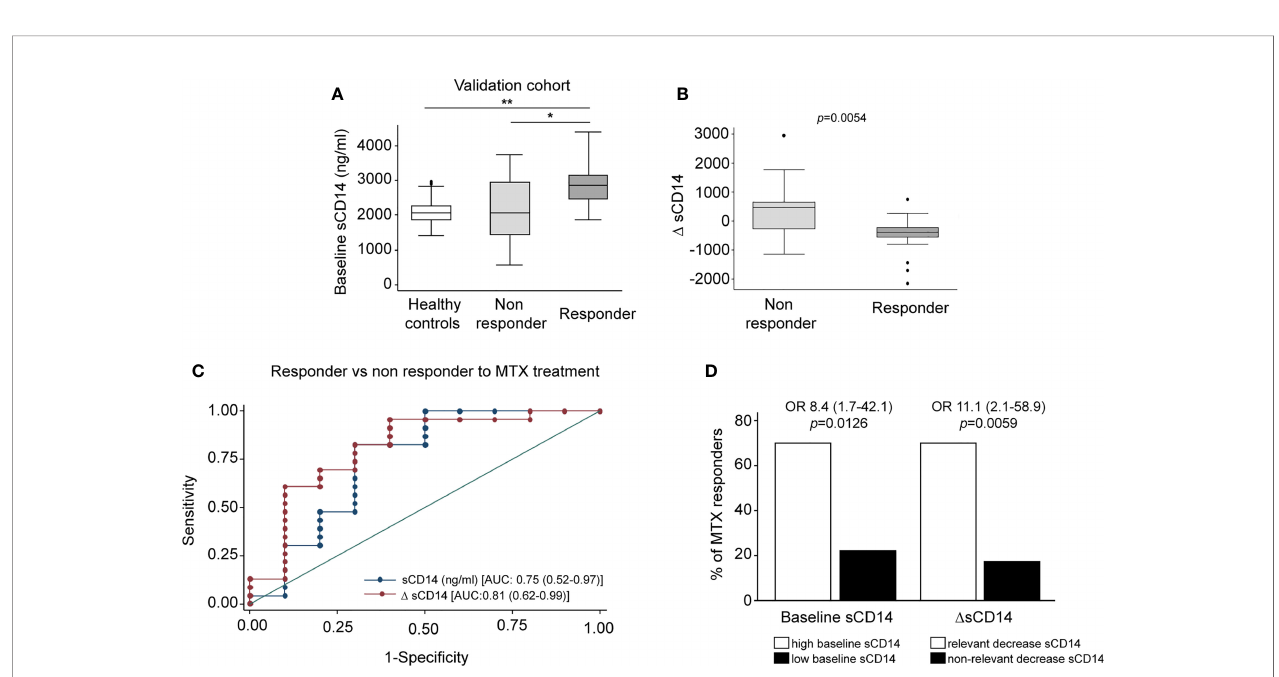
FIGURE 8 | Serum level of sCD14 decreases in RA patients who are MTX responders in a validation cohort. (A) Baseline sCD14 in healthy donors (white box, n = 40), MTX-non-responder (soft gray box, n = 10), and MTX-responder (dark gray box, n = 23) RA patients. Statistical signi fi cance respect to MTX-responders was determined through Mann – Whitney test (* p < 0.05; ** p < 0.01). (B) Variation in sCD14 between baseline and 6 months ’ follow-up visits ( D sCD14: sCD14 value in 6- month visit − sCD14 value at baseline visit) in MTX-non-responder (soft gray box) and MTX-responder (dark gray box) RA patients. Data in panels A and B are shown as interquartile range (p75 upper edge of box, p25 lower edge, and p50 midline) as well as the p95 (line above box) and p5 (line below). (C) Receiver operating characteristic curve analysis to assess capacity of baseline sCD14 (blue line and dots) and D sCD14 (red line and dots) to discriminate between MTX- responder and MTX-non-responder RA patients. (D) Comparison of the percentage of MTX responders in patients with high (left white bar) versus low (left black bar) baseline sCD14 and in patients with relevant decrease of sCD14 (right white bar) versus non-relevant variation of sCD14 (right black bar). The cutoff for discriminating high and low sCD14 was 2,460 ng/ml, and the one to discriminate between relevant and not relevant decrease of sCD14 was 188 ng/ml, as described in the last section of Results . OR and its CI were estimated with the cs command of Stata 14.1 and the signi fi cance level with Fisher ’ s test. sCD14, soluble CD14; RA, rheumatoid arthritis; MTX,